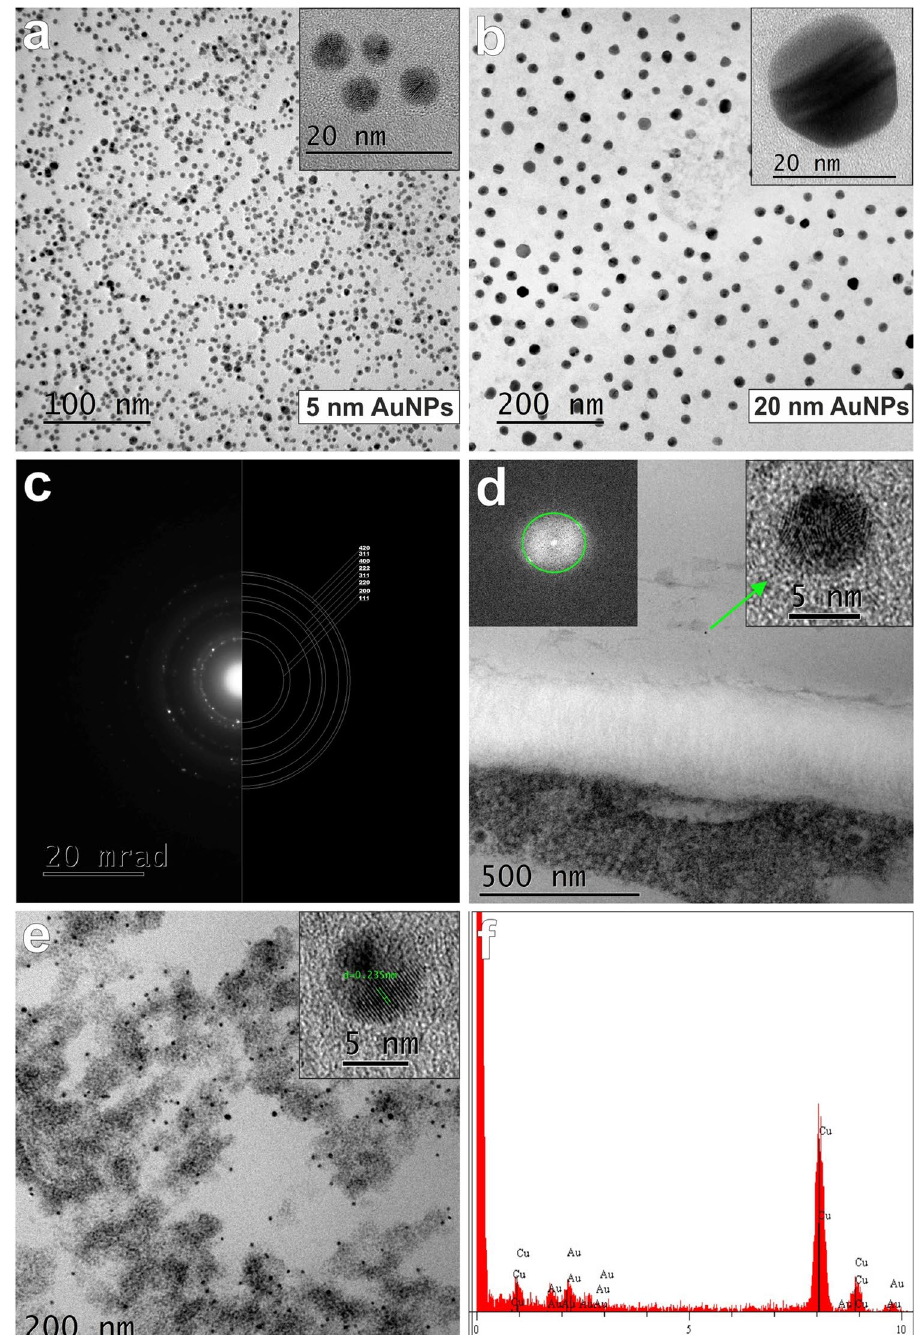
Figure 1. High-resolution images of the gold nanoparticles that were used in the presented studies. ( a ) 5 nm AuNPs bright field. ( b ) 20 nm AuNPs bright field. ( c ) Recorded diffraction pattern with corresponding theoretical rings for the Au structure. The diffraction pattern clearly supports the claim that the observed NPs are gold. ( d , e ) Evidence of the presence of AuNPs in root cells. ( d ) Single AuNP localised in the vicinity of the cell wall. HRTEM image of an AuNP with the calculated Fourier transform in the insert in the upper left-hand corner. A green circle indicates a 0.23 nm interplanar distance, which permitted the presented AuNPs to be identified. ( e ) Parenchyma cell with numerous AuNPs in the cytoplasm. The presented high-resolution images and analysis of the automatic interplanar distance indicate that the observed particles are AuNPs (the insert). ( f ) EDS-TEM analysis of the nanoparticles in the cytoplasm of the root cells. ( a,b,d,e ) Inserts in the top right- hand corners show high-resolution images of the selected